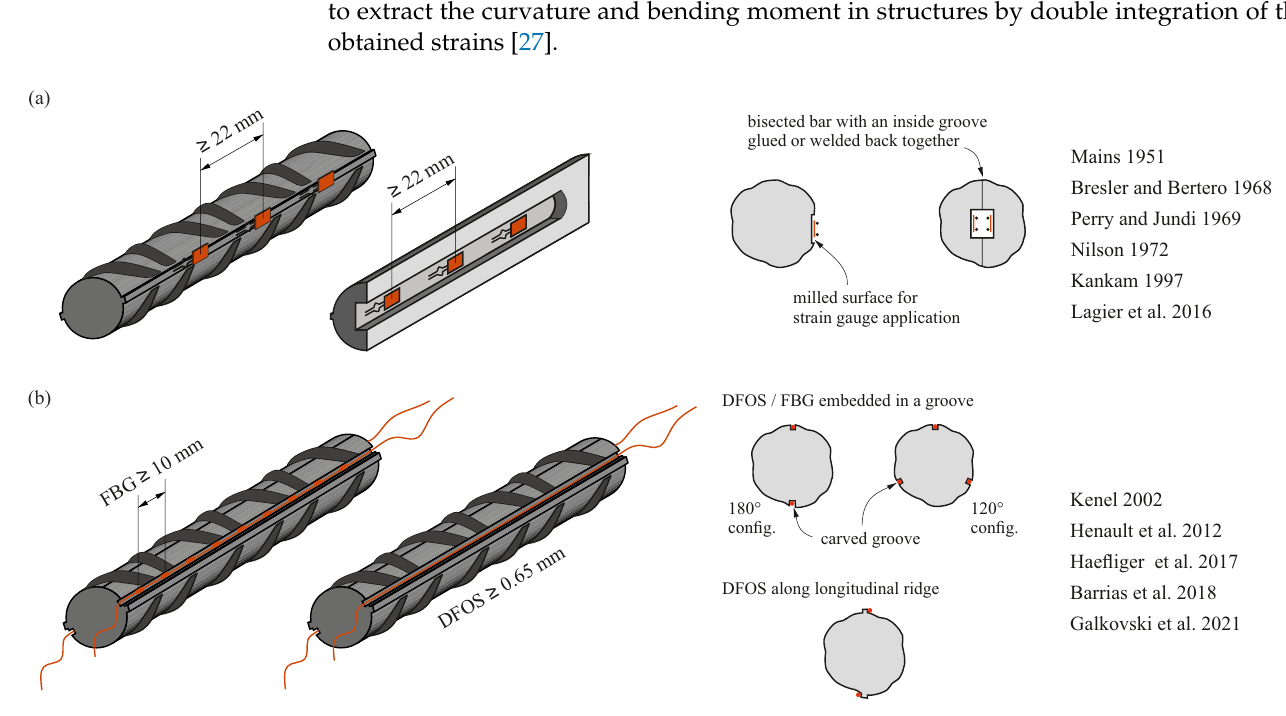
Figure 1. Methods to directly assess the strain distribution of reinforcing bars embedded in concrete (as examples without claiming completeness): ( a ) strain gauges glued on and inside a reinforcing bar [1–6]; and ( b ) fibre optical sensors installed on a reinforcing bar using either fibre Bragg gratings (FBG) [10] or Distributed Fibre Optical Sensing (DFOS)